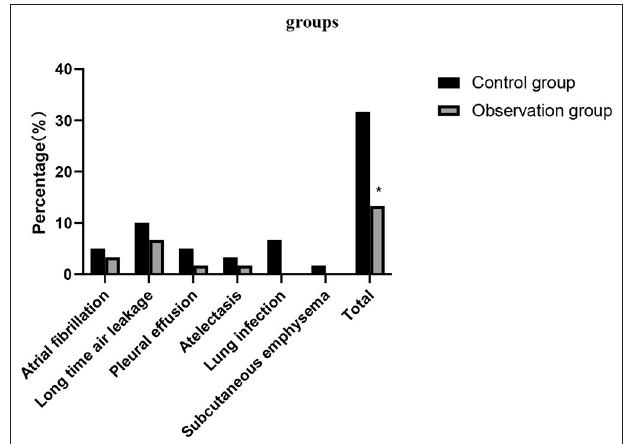
FIGURE 5 | Comparison of MVV changes in the patients of the two groups. Compared with preoperative, * p < 0.05. Compared with the control group, # p < 0.05.